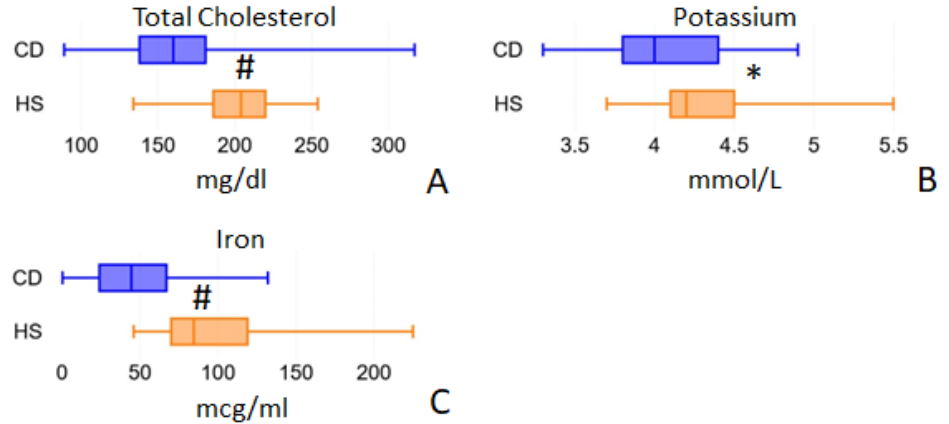
Figure 4. Average daily values of ORAC (Oxygen Radical Absorbance Capacity, panel A ) and PRAL (Potential Renal Acid Load, panel B ) calculated by the Metadieta software for the food diaries analyzed for the two populations under study. # = p < 0.01.